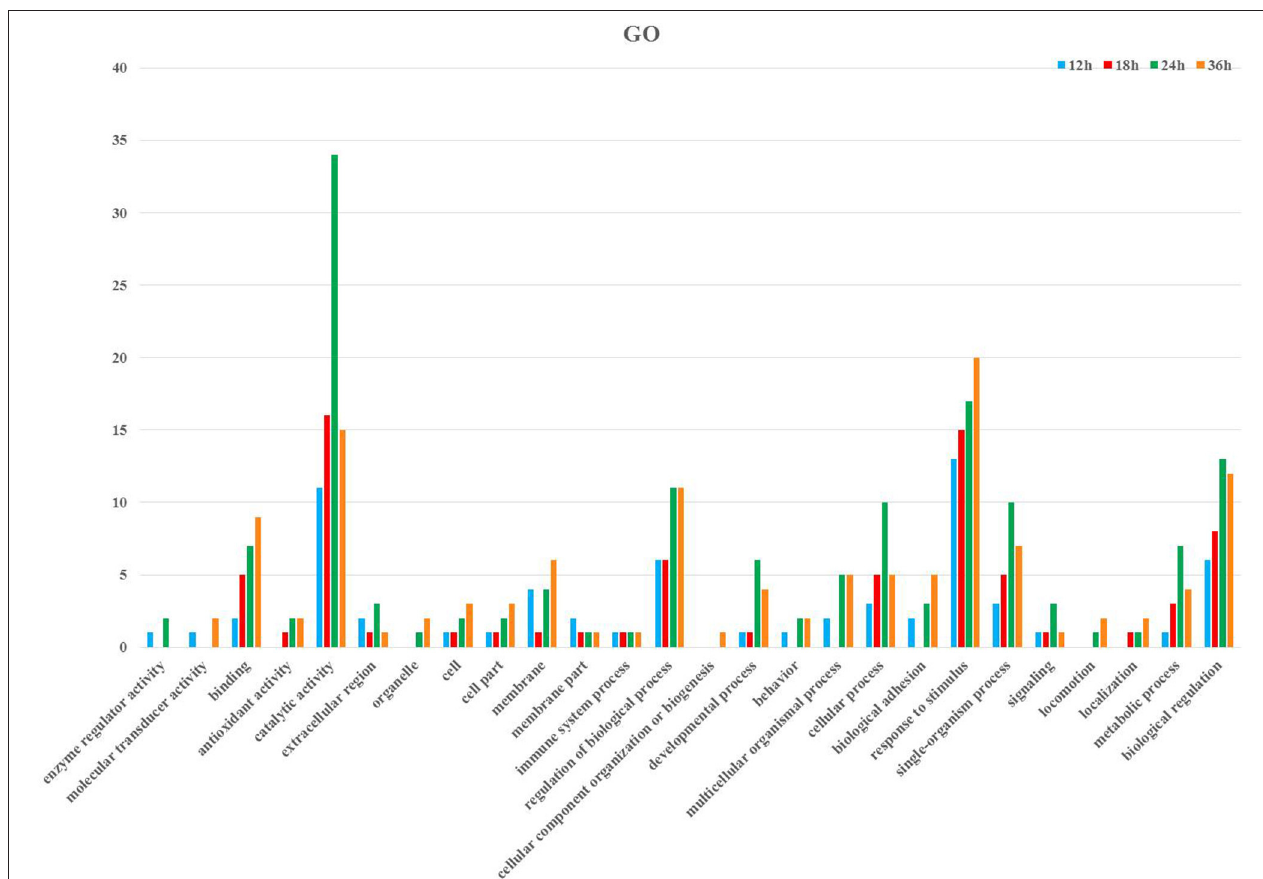
FIGURE 3 | Summary of Gene ontology annotation. Functional classification of immunity- related DEGs at 12, 18, 24, and 36 h post-infection in P. xylostella using gene ontology